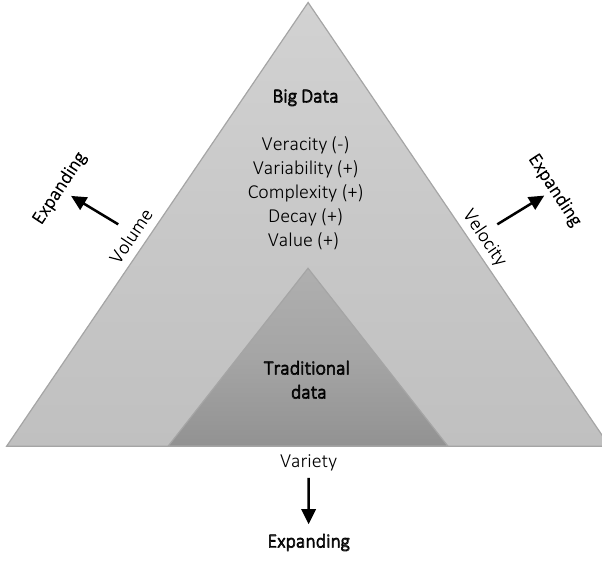
Figure 1. Big data in an integrated